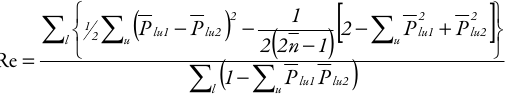
Tab. 1 . Estimates of allele frequencies of ABO gene in Barak Valley Muslims (BVM) and other 24 populations/nations